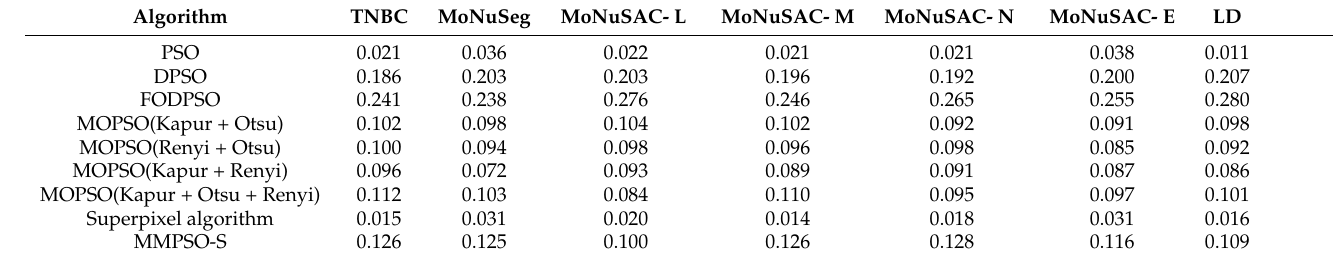
Table 8. Comparison of algorithms in terms of normalised execution time (in seconds) per